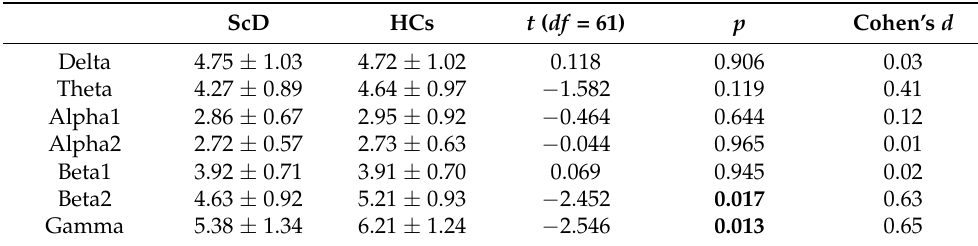
Table 3. Global omega complexity of the ScD and HCs groups.